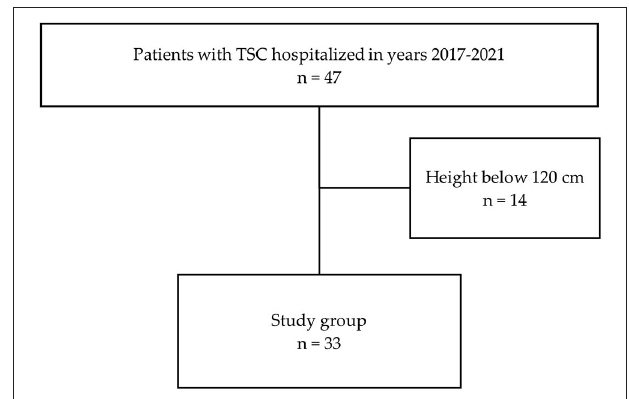
FIGURE 1 | Flowchart of the patients’ recruitment (TSC—tuberous sclerosis complex).